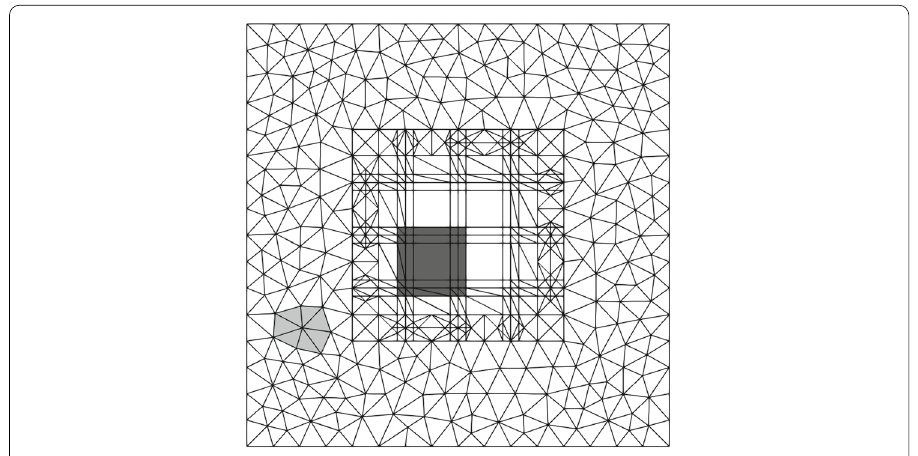
Fig. 6 Sketch of the blended function discretization space depicting the supports of a basis function ∈ V φ ∈ V φ HOST HOST (light gray) and ENR ENR (dark gray). The support sizes are of comparable size throughout the paper; i.e. diam(supp( φ HOST ) ∼ diam(supp( φ ENR )